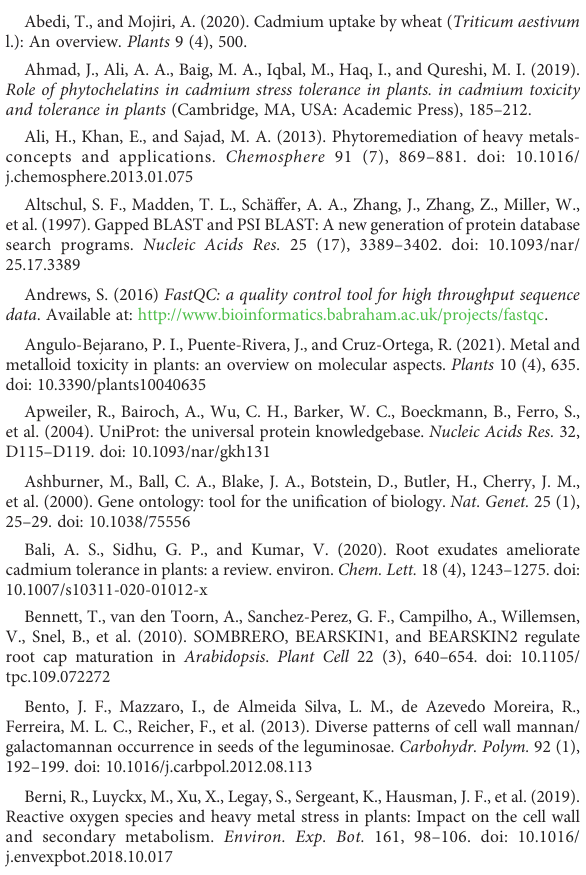
SUPPLEMENTARY FIGURE 1 Gene ontology classi fi cation of differentially expressed genes. *, the higher percentage of genes. SUPPLEMENTARY FIGURE 2 Histogram of the number of transcription factors for differentially expressed genes. SUPPLEMENTARY FIGURE 3 Heatmap of the Module-Trait correlation. AvgDiam, Average diameter; CdRoot, CdStem, and CdLeaf indicate the Cd concentration in roots, stems, and leaves,